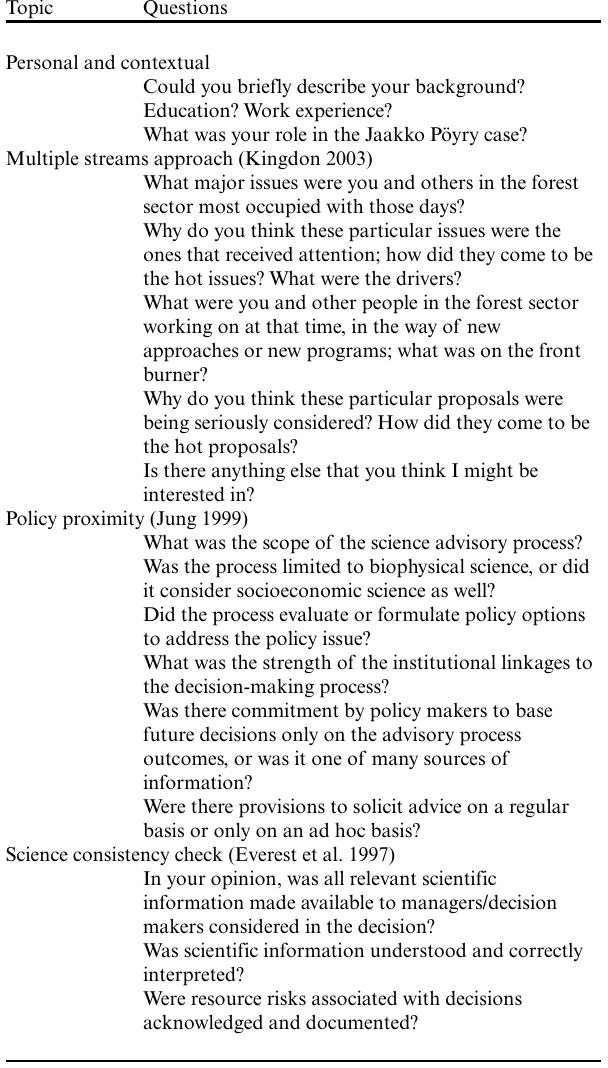
Table 2 . Summary of interview